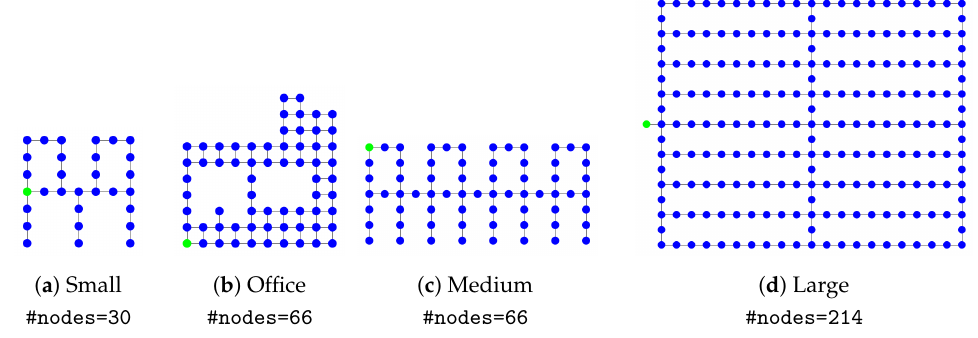
Figure 15. The warehouse problems from Claes et al. [8]. Green nodes represent depot